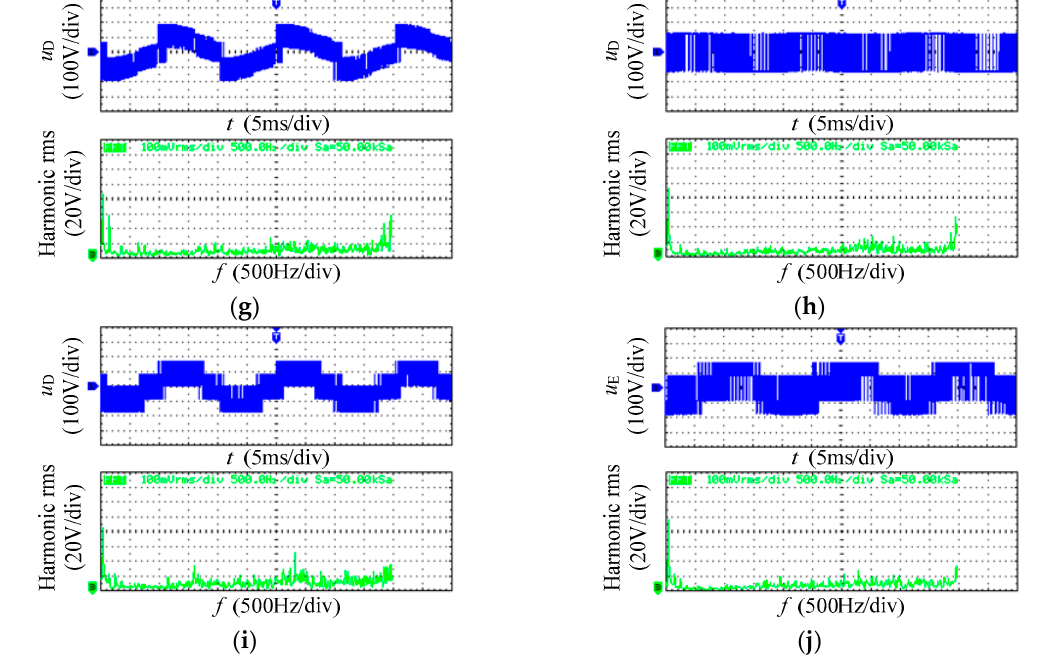
Figure 15. Stator winding voltages and their FFT analysis in experiments 1 and 2. ( a ) A-phase voltage and its FFT in experiment 1; ( b ) A-phase voltage and its FFT in experiment 2; ( c ) B-phase voltage and its FFT in experiment 1; ( d ) B-phase voltage and its FFT in experiment 2; ( e ) C-phase voltage and its FFT in experiment 1; ( f ) C-phase voltage and its FFT in experiment 2; ( g ) D-phase voltage and its FFT in experiment 1; ( h ) D-phase voltage and its FFT in experiment 2; ( i ) E-phase voltage and its FFT in experiment 1; ( j ) E-phase voltage and its FFT in experiment 2.